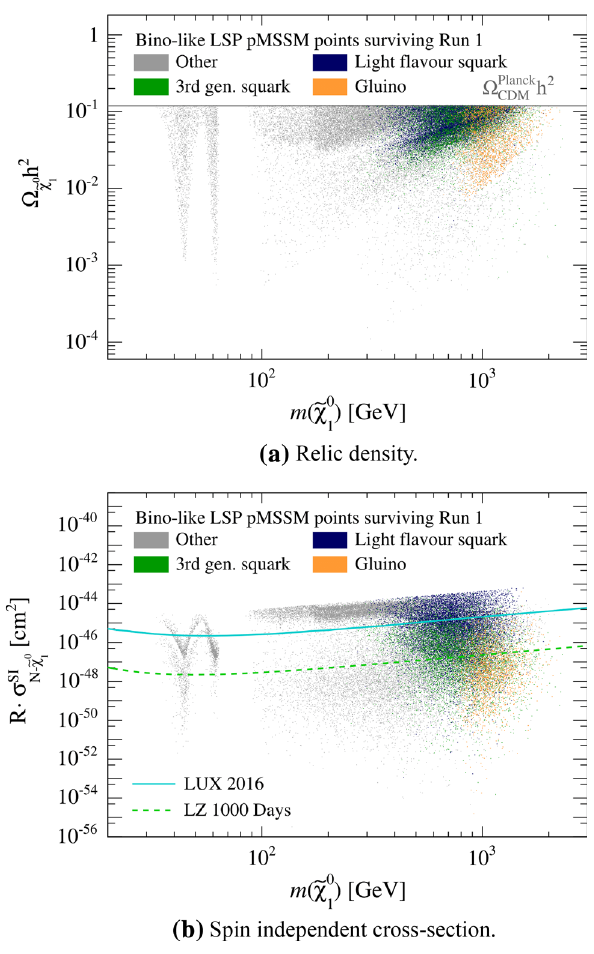
Fig. 9 The strongly interacting coannihilators of points with a bino- like LSP surviving Run 1 constraints, projected into relic density ( left ) and spin-independent LSP-nucleon cross section ( right ) vs. LSP mass ) . The points are coloured according to dominant coannihilator m ( ˜ χ 0 1 for the LSP:gluino ( light orange ), light flavour squarks ( dark blue ), third generation squarks ( green ) and ‘other’ refers to (co)annihilation mechanisms involving the electroweak